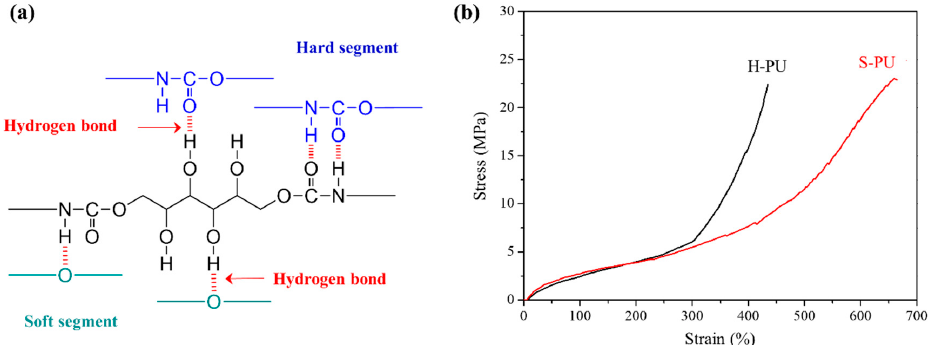
Figure 2. Characteristics of S-PU investigated: ( a ) possible hydrogen bonds in S-PU; ( b ) tensile properties of S-PU and H-PU at 25 °C.